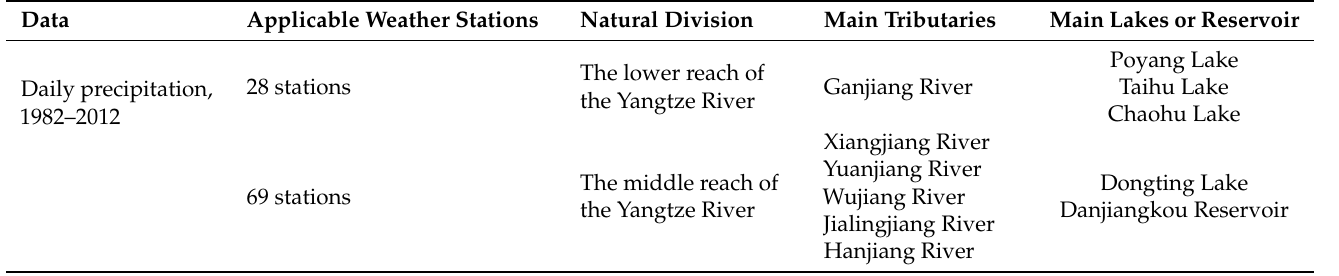
Table 1. Distribution of weather stations in the MLR-YR.